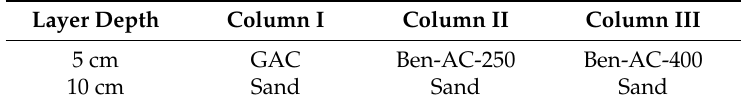
Table 4. Solid phase extraction (SPE) and chromatographic analysis